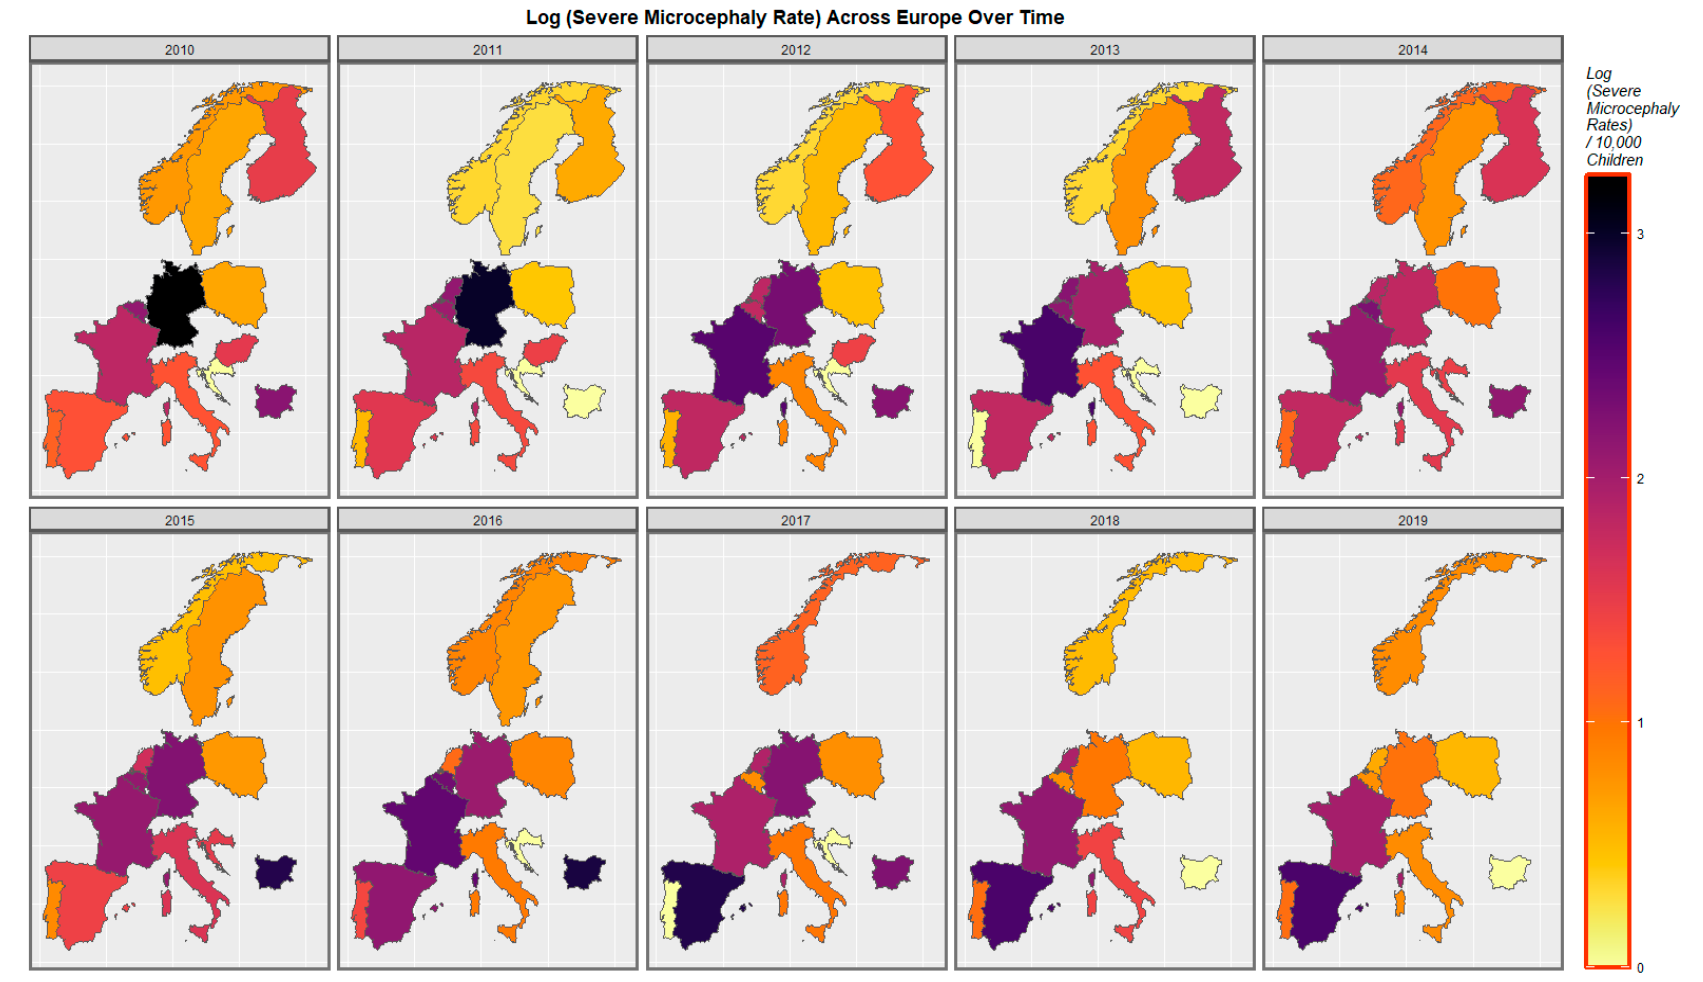
Figure 4. Sequential map-graphs of log (severe microcephaly rates) across surveyed European nations over time, 2010–2019.